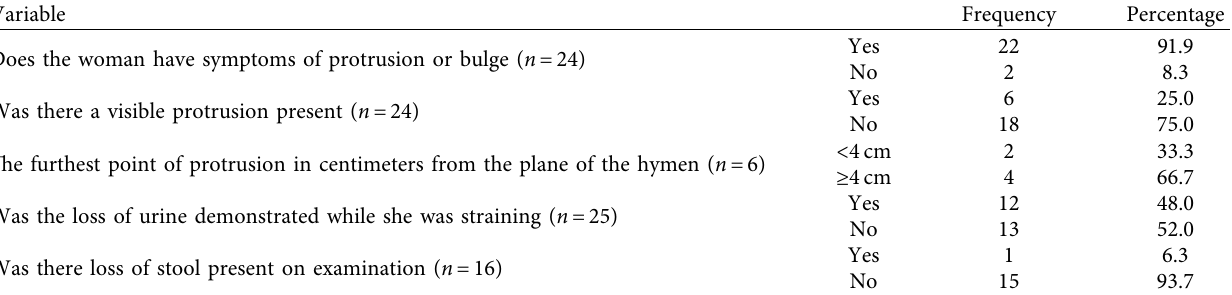
Table 4: Signs of PFD during physical examination among study participants.